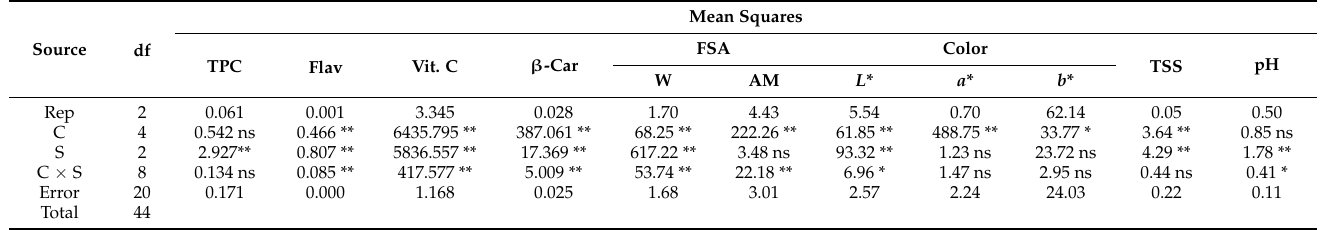
Table 3. Analysis of variance for the effect of cultivar and storage duration on sweet melon fruit quality parameters, plus nutritional and phytochemical contents.